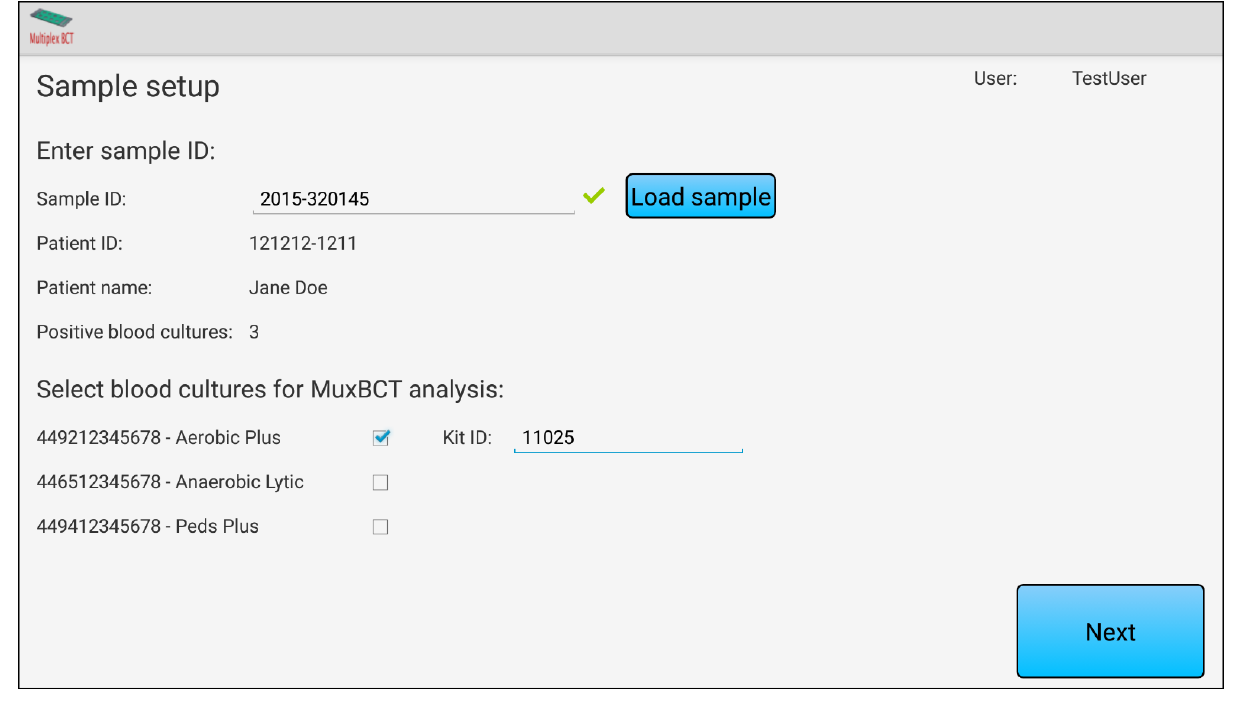
Figure 1. Sample screenshot of the Multiplex Blood Culture Test (MuxBCT) app showing the initial sample setup where a sample ID is entered into the system, data are retrieved from the Laboratory Information System (LIS), and displayed in the app. The patient information displayed in the image is